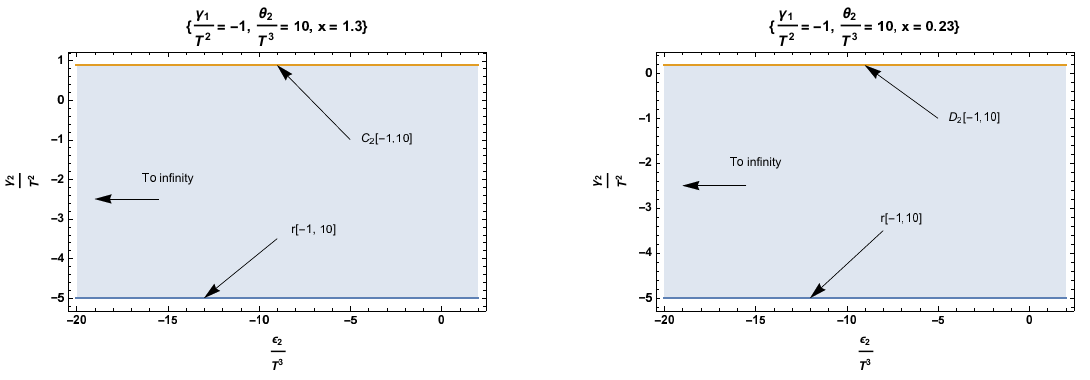
Figure 9 . Acceptable zones in the case of finite µ 0 and T 0 . Boundaries are given in terms of table 1 data. For ˜ γ 1 < 0 the accessible zone has infinite area which shows the favorablity of this